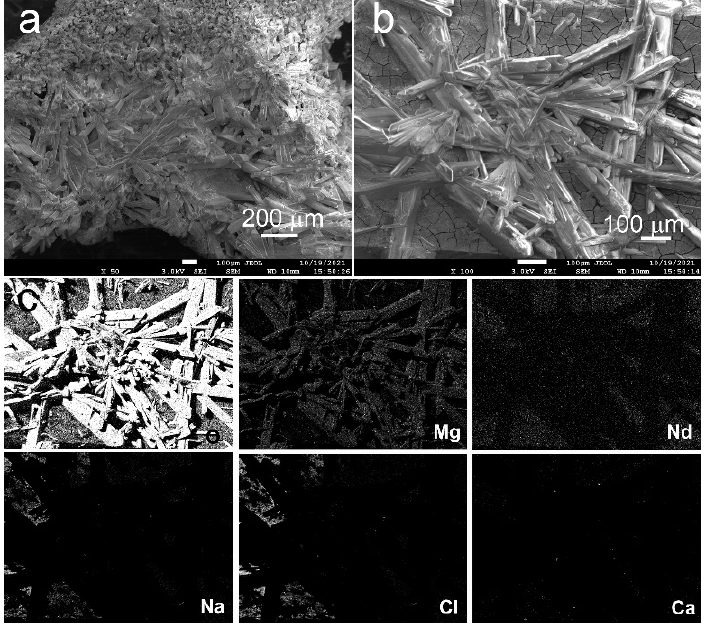
Figure 7. Appearance of WE43 MAD degradation products ( a , b ) and elemental mapping ( c ) after 13 days of incubation in